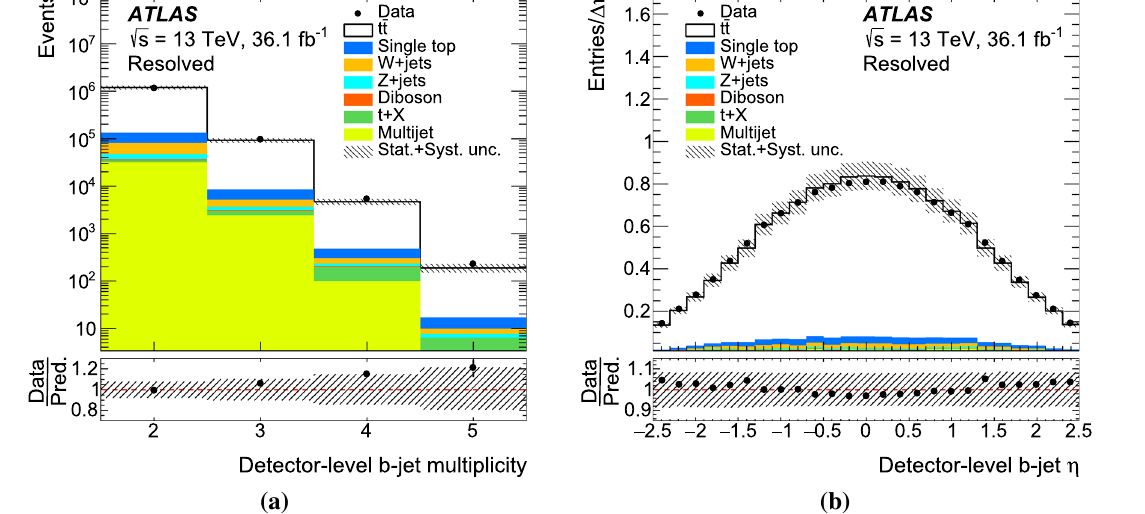
in Sect. 9) in the total prediction, excluding systematic uncertainties relatedtothemodellingofthe t ¯ t events.Underflowandoverflowevents, if any, are included in the first and last bins. The lower panel shows the ratio of the data to the total prediction